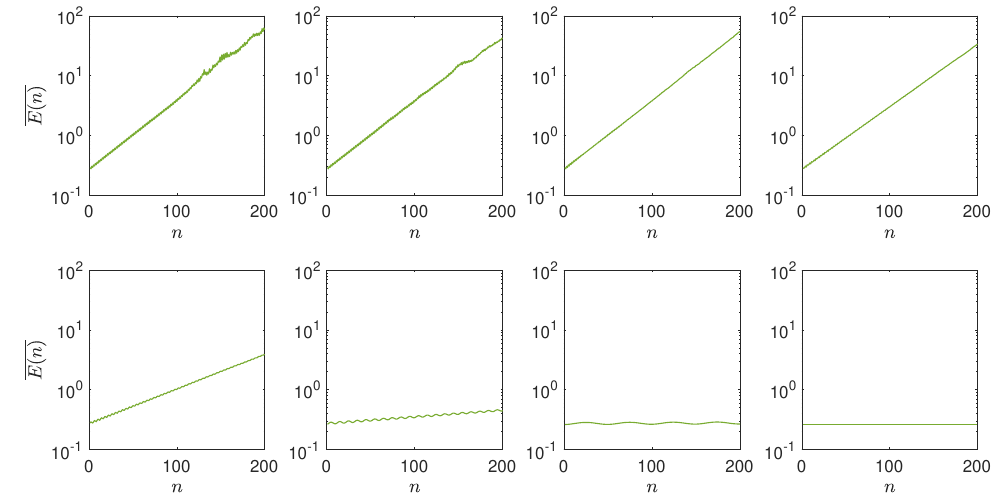
Figure 8: Time evolution of the ensemble-averaged energy in (30) in a randomly driven CFT. The driving protocol and parameters are the same as those in Fig.